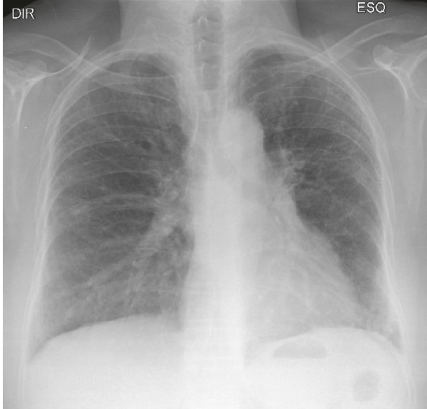
Figure 5: Posteroanterior CXR. Multifocal bronchovascular lack of